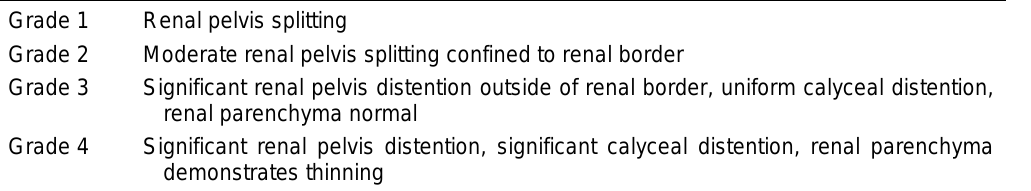
FIGURE 3 . SFU grading system for hydronephrosis.